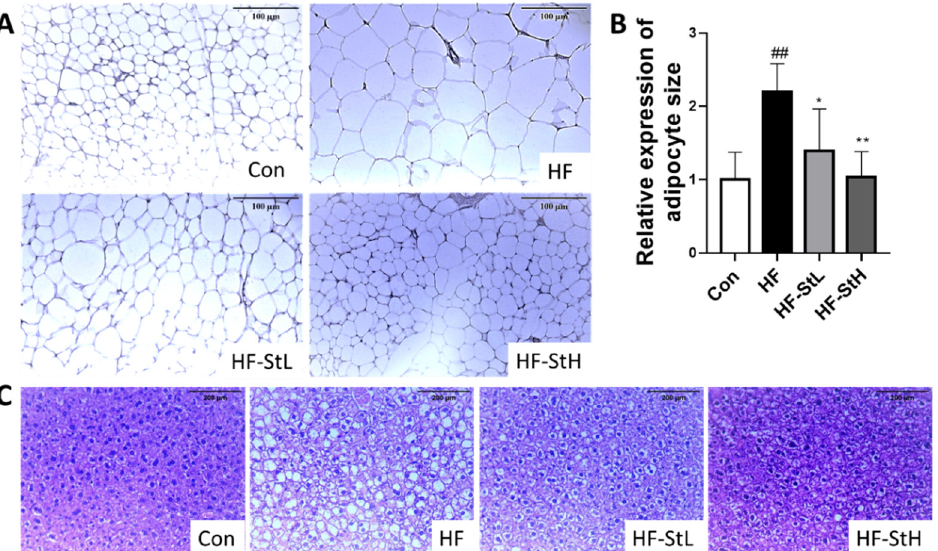
Figure 5. Histological changes in white adipose tissue (WAT) and liver in high-fat-fed C57BL/6 mice. ( A ) White adipose tissue section by H&E staining ( × 100). ( B ) Average adipocyte size. ( C ) Liver section by H&E staining ( × 200). Con: chow diet, HF: high-fat diet, HF-StL: high-fat diet+ST extract 150 mg/kg bw, HF-StH: high-fat diet+ST extract 300 mg/kg bw. All data are presented as means ± SD (n = 10). Compared between the control and the high-fat diet group, ## p < 0.01 by student t -test. Compared with the high-fat diet group, * p < 0.05, ** p < 0.01 by one way ANOVA followed by Dunnett’s test.